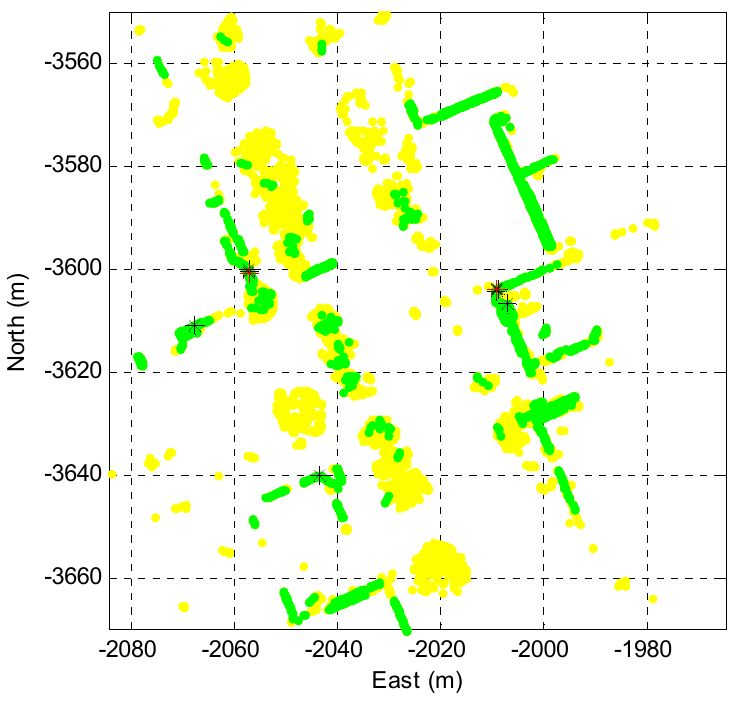
Figure 9. Corner extraction result.